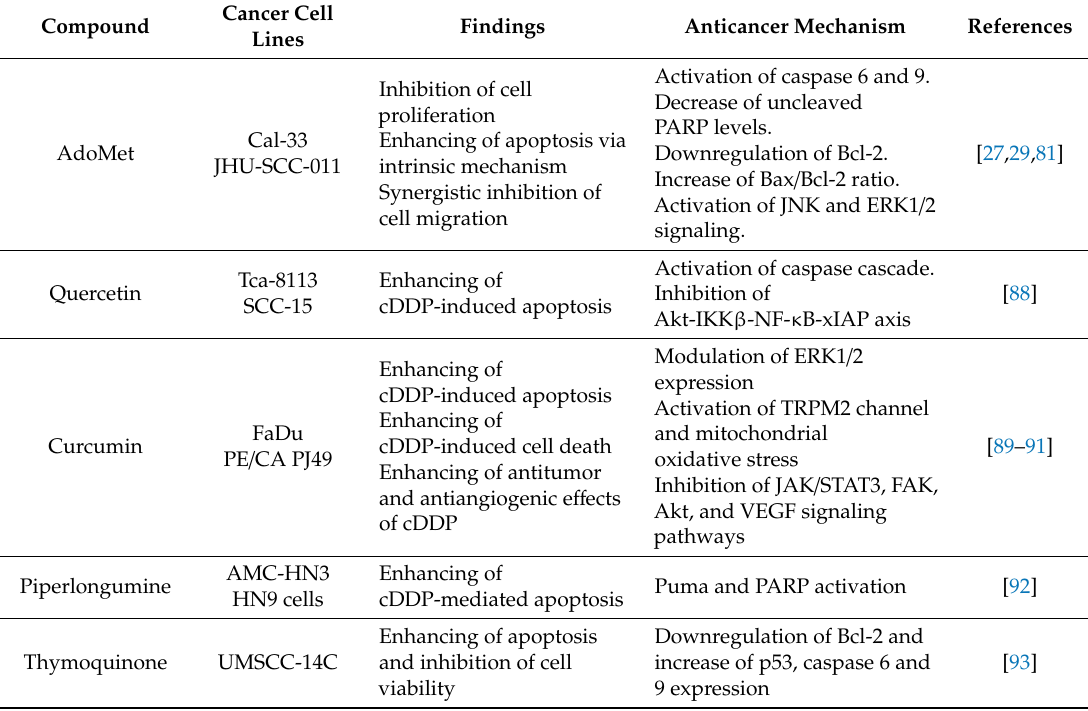
Table 2. E ff ect of AdoMet and emerging phytochemicals in combination with cDDP in head and neck